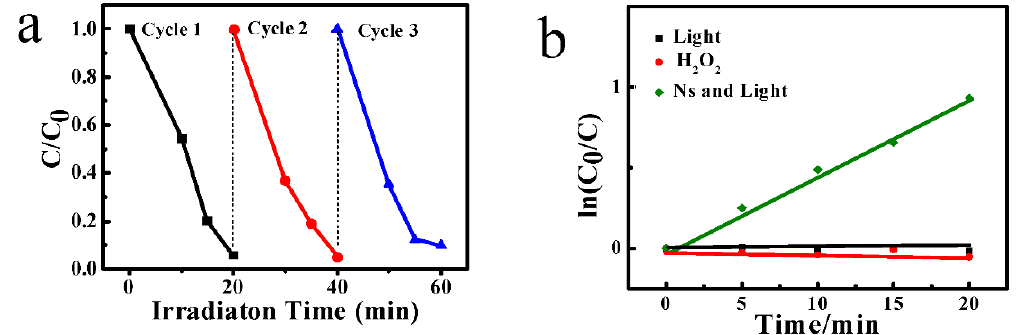
Figure 6. ( a ) Cyclic degradation efficiency of Ns under simulated solar irradiation; ( b ) The effect of light and H 2 O 2 on the degradation efficiency of the catalyst.